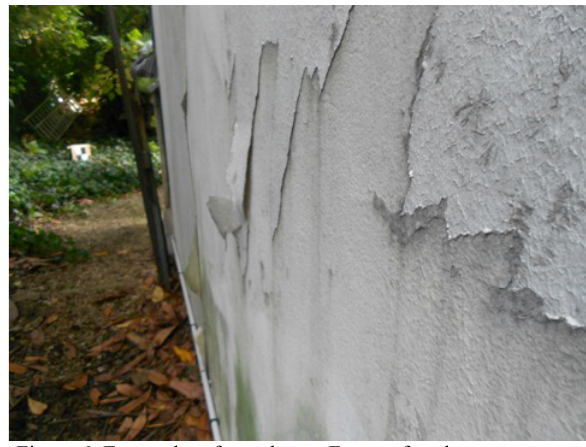
Figure 6. External surfaces decay, Eastern façade, current